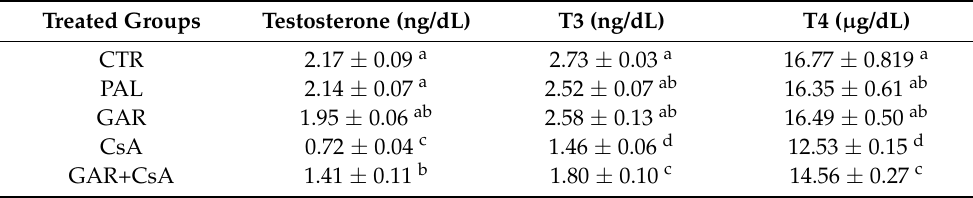
Table 4. Effect of treatment with Cyclosporine (CsA) and/or Garlic on serum levels of testosterone and concentrations of T3 and T4 in male Westar albino rats. Treated Groups